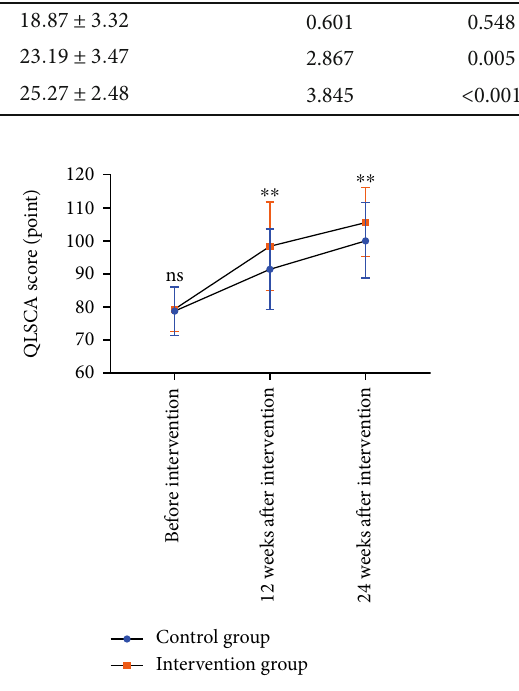
e ff ect: F = 5 : 206 , P = 0 : 006 ) (Table 5 and Figure 4).